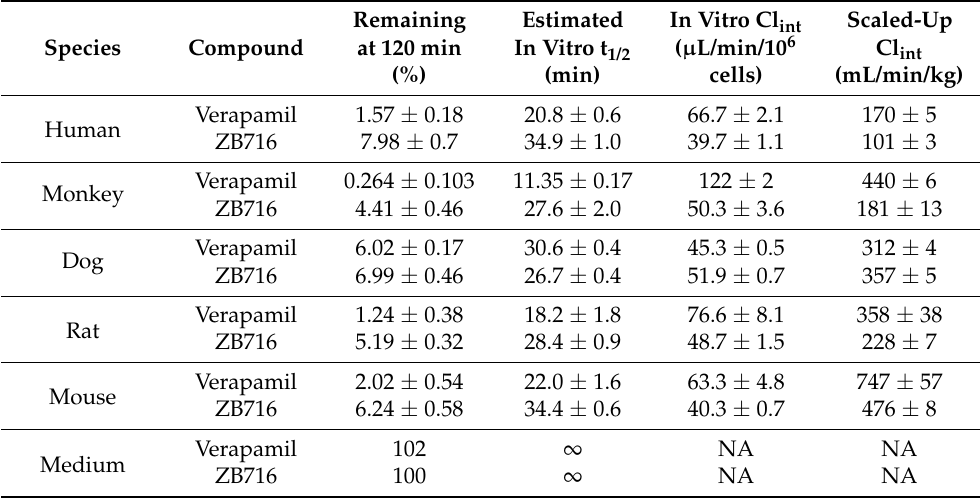
Table 13. Metabolism information of ZB716 in human, monkey, dog, rat, and mouse hepatocytes (mean, n = 3). Species Compound